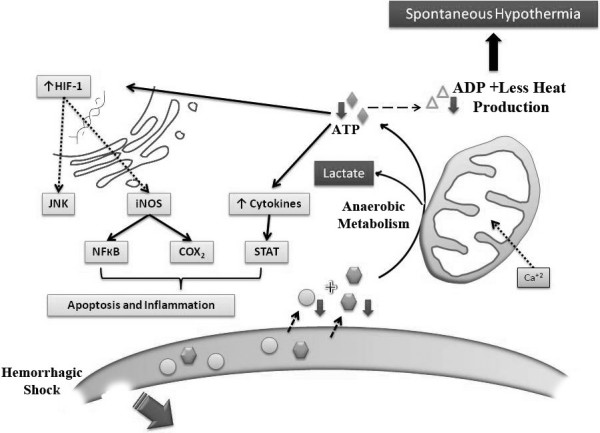
Hemorrhage reduces availability of oxygen and substrates and stimulates a switch to anaerobic metabolism leading to decreased ATP synthesis and subsequent heat production. This cellular hypoxia also stabilizes HIF-1, which activates several inflammatory and apoptotic pathways leading to increased cell injury and death. ATP = Adenosine Tri-Phosphate. ADP = Adenosine Di-Phosphate. HIF-1 = Hypoxia-Induced Factor-1. iNOS- induced Nitric Oxide Synthase. NO = Nitric Oxide. PG = Prostaglandin. NF-kB = Nuclear Factor- kappa B. COX-2 = cyclo-oxygenase-2. IL = Interleukins. TNFα = Tumor Necrosis Factor alpha. G-CSF = Granulocytes Colony Stimulating Factor. STAT = Signal Transducers and Activators of Transcription.